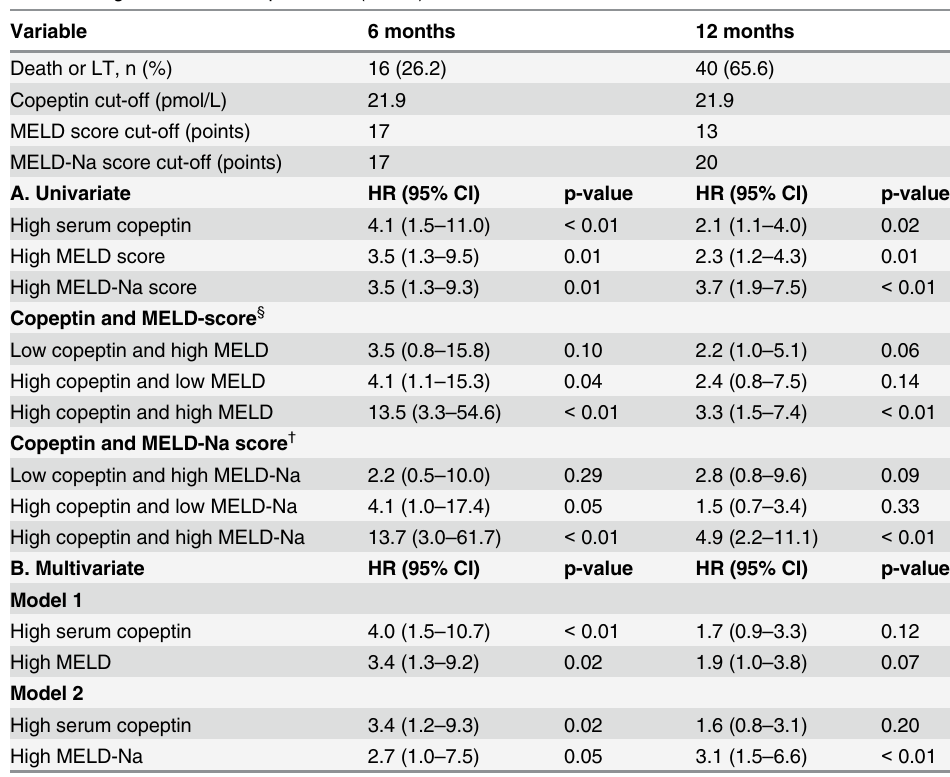
LT , liver transplantation; HR , hazard ratio; 95% CI , 95% con fi dence interval; high , exceeding the optimal cut-off point; low , equal to or below the optimal cut-off point; MELD , Model for End-Stage Liver Disease; MELD-Na , sodium MELD §, † “ Low ” and “ high ” refers to values below and above the optimal cut-off point as de fi ned using the Youden index, respectively. The reference groups were patients with low serum copeptin and § low MELD score or † low MELD-Na